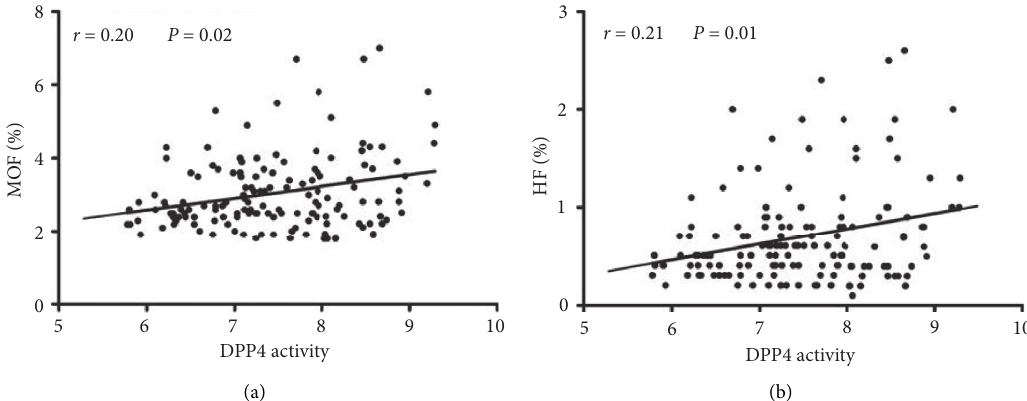
Figure 2: Correlations of plasma DPP4 activity with the 10-year probability of MOF (a) and HF (b) in all participants (calculated by Spearman’s correlation